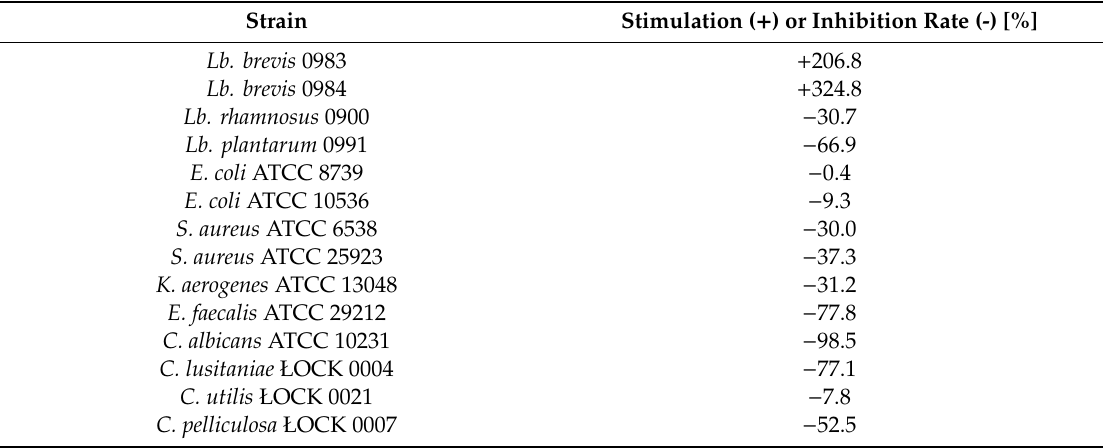
Table 2. Stimulation / inhibition of adherence to Caco-2 cell monolayers for tested microbial strains in the presence of SBP hydrolysate.